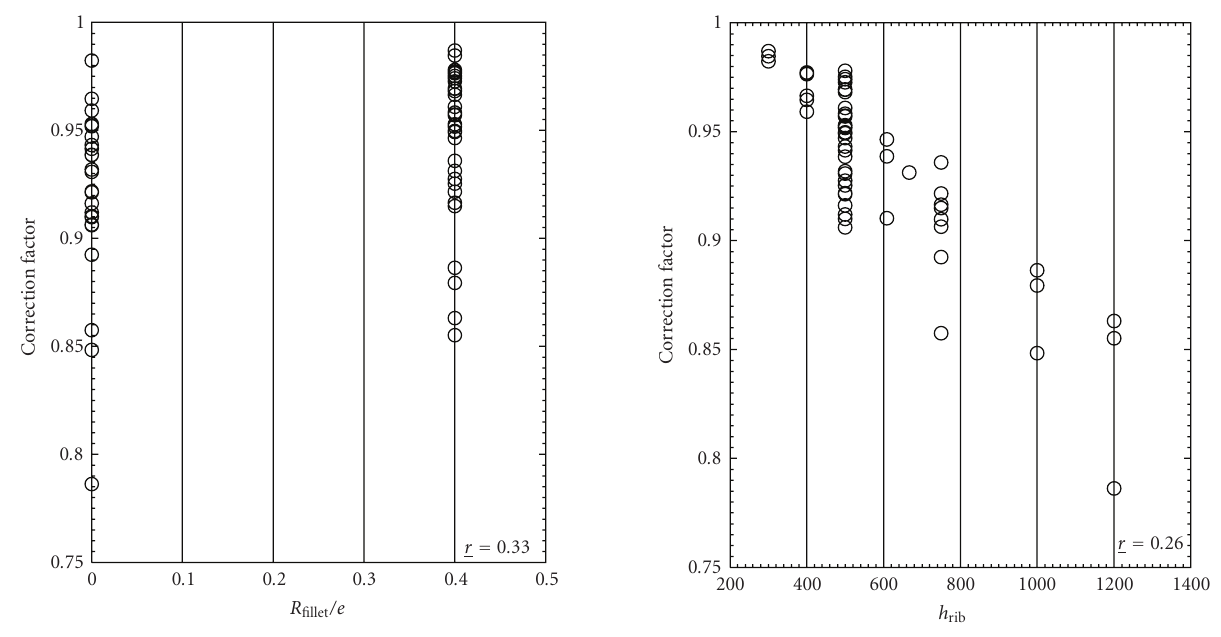
Figure 10: Correction factor variation with R fillet /e for the set of chosen data.